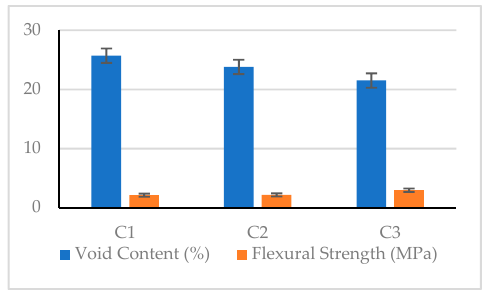
Figure 12. Relationship between flexural strength and void content.